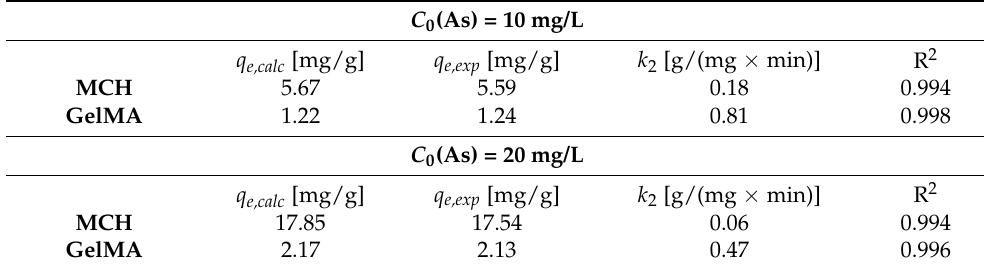
Table 2. Pseudo-second order fitting parameters for As(V) adsorption.